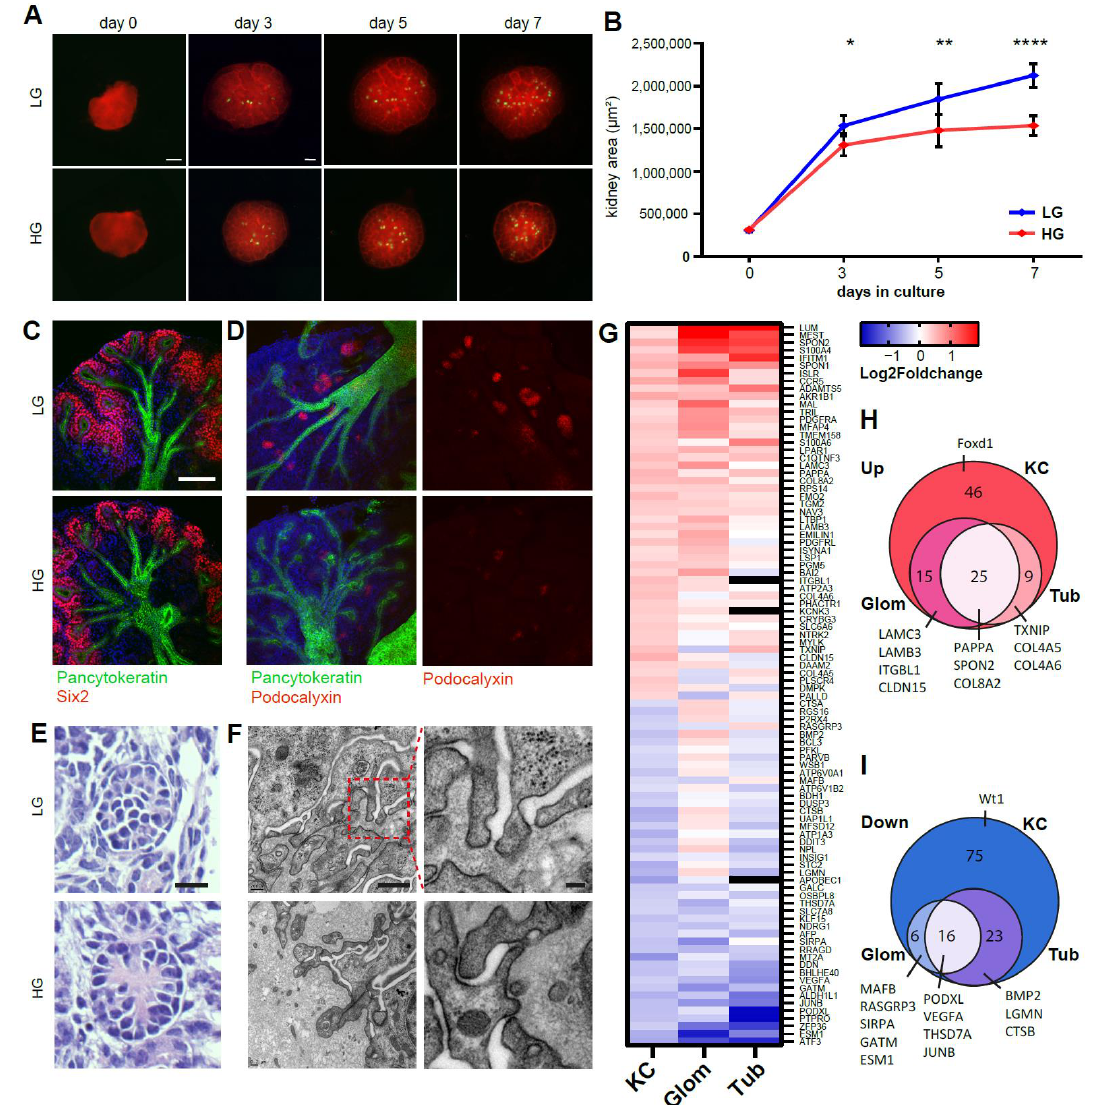
Figure 2. Ex vivo high glucose exposure leads to diabetic nephropathy-associated changes in the developing kidney. ( A ) Embryonic kidneys from Pod.Cre;Tomato/EGFP animals cultured for 7 days in low glucose (LG, 5.5 mM α -D-glucose, 55 mM mannitol) or high glucose (HG, 55 mM α -D-glucose) conditions. Scale bar: 500 µm. ( B ) Kidney surface area of HG and LG conditions. *, p = 0.0474; **, p = 0.0052; ****, p < 0.0001. Paired t -test, mean ± SD. ( C ) Confocal immunofluorescent stainings of day 7 kidney cultures against Six2 and ( D ) podocalyxin with pan-cytokeratin and Hoechst. Scale bar: 100 µm. ( E ) Stainings of 6 µm sections from day 7 kidney cultures. Scale bar: 20 µm. ( F ) Transmission electron microscopy of sections from day 7 kidney cultures. Glomerular basement membranes are thickened in kidneys exposed to high glucose conditions. Left column: magnification showing podocyte foot processes. Scale bars: 500 nm (left panels), 100 nm (right panels). ( G ) Fold change of RNA-seq data from HG compared to LG kidneys and ERCB diabetic nephropathy (DN) patient microarray data from microdissected glomeruli and tubules showing differentially expressed genes. ( H ) Genes upregulated in the kidney cultures (KC) overlapping with ERCB DN patient data and selected genes highlighted. ( I ) Genes downregulated in the kidney cultures (KC) overlapping with ERCB DN patient data and selected genes